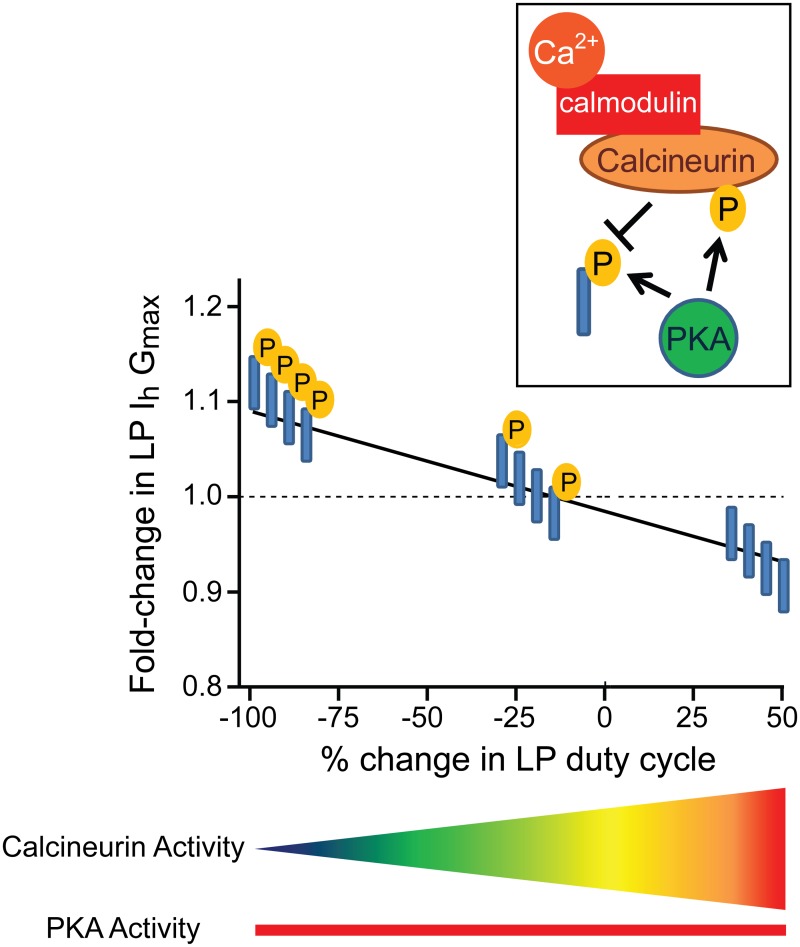
The simplest working model for how tonic nM DA acts through PKA and calcineurin to enable bi-directional, activity-dependent regulation of LP Ih Gmax.The graph represents the LP Ih Gmax activity dependence curve in 5nM DA (taken from Fig. 3B). The line indicates the idealized fold change in LP Ih Gmax observed in response to a 10min alteration in LP duty cycle. The boxed inset shows the putative molecular mechanism that is activated by tonic 5nM DA. First, DA acts through LP D1Rs to activate PKA. In turn, PKA phosphorylates an unknown protein (blue cylinder) to increase LP Ih Gmax. PKA also phosphorylates calcineurin, a phosphatase that is regulated by the Ca2+-calmodulin complex. PKA phosphorylation permits calcineurin regulation of LP Ih Gmax. When calcineurin is activated by both PKA and Ca2+-calmodulin, it dephosphorylates the unknown protein to reduce LP Ih Gmax. In the absence of PKA, calcineurin cannot influence LP Ih Gmax. The phosphorylation state of the unknown protein is superimposed upon the LP Ih Gmax activity-dependence curve in 5nM DA. Ca2+ is lowest at-100 and highest at +50, and the gradient below the graph indicates how calcineurin activity changes with LP duty cycle. PKA activity is constant because 5nM DA is tonically present (red bar). The unknown protein is fully phosphorylated at-100 because PKA is active but calcineurin is not. At +50 the unknown protein is completely dephosphorylated because calcineurin activity is maximal. In the idealized state, the unknown protein is partially phosphorylated at baseline (0). This phosphorylation is not DA-dependent. Instead, DA acts to increase baseline phosphorylation of the unknown protein through PKA and to enable activity-dependent regulation of the unknown protein’s phosphorylation state by calcineurin. In the absence of DA, the unknown protein maintains its baseline phosphorylation regardless of LP activity.